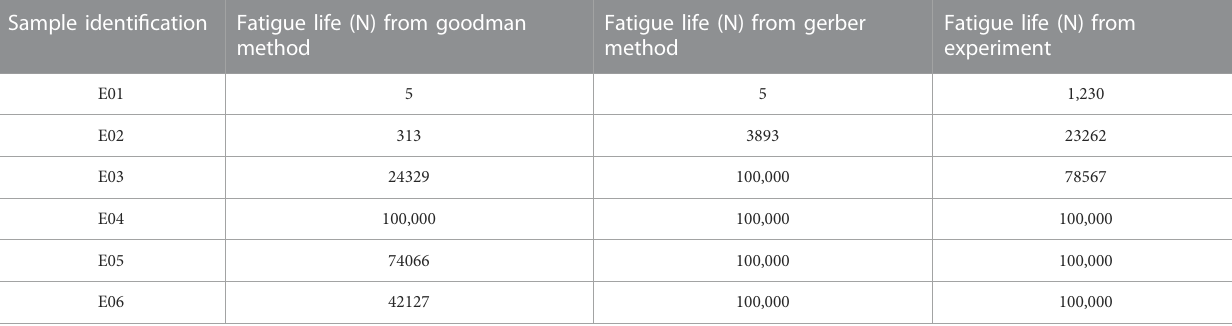
TABLE 4 Numerical and experimental fatigue life for the six samples.